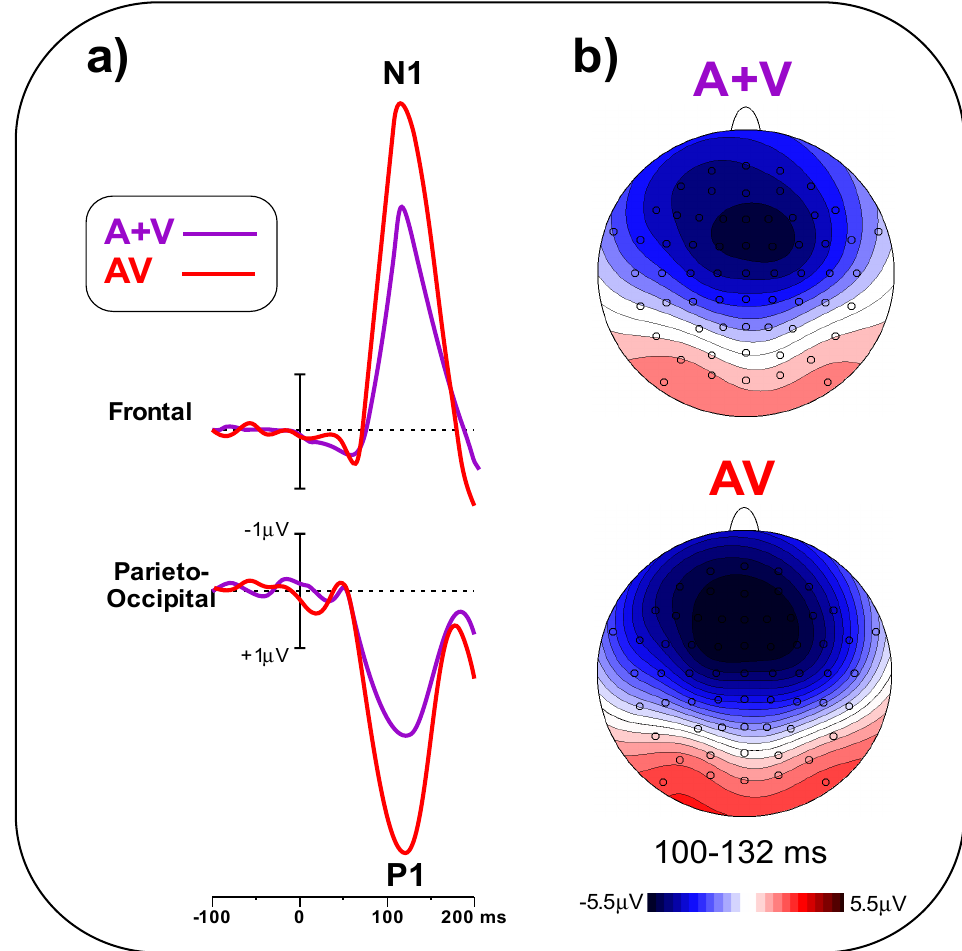
Figure 5. ( a ) AV and A + V post-stimulus ERPs in the frontal and parieto-occipital pools. ( b ) Topo- graphical distribution of the P1 and the N1 components in the 100–132 ms interval.